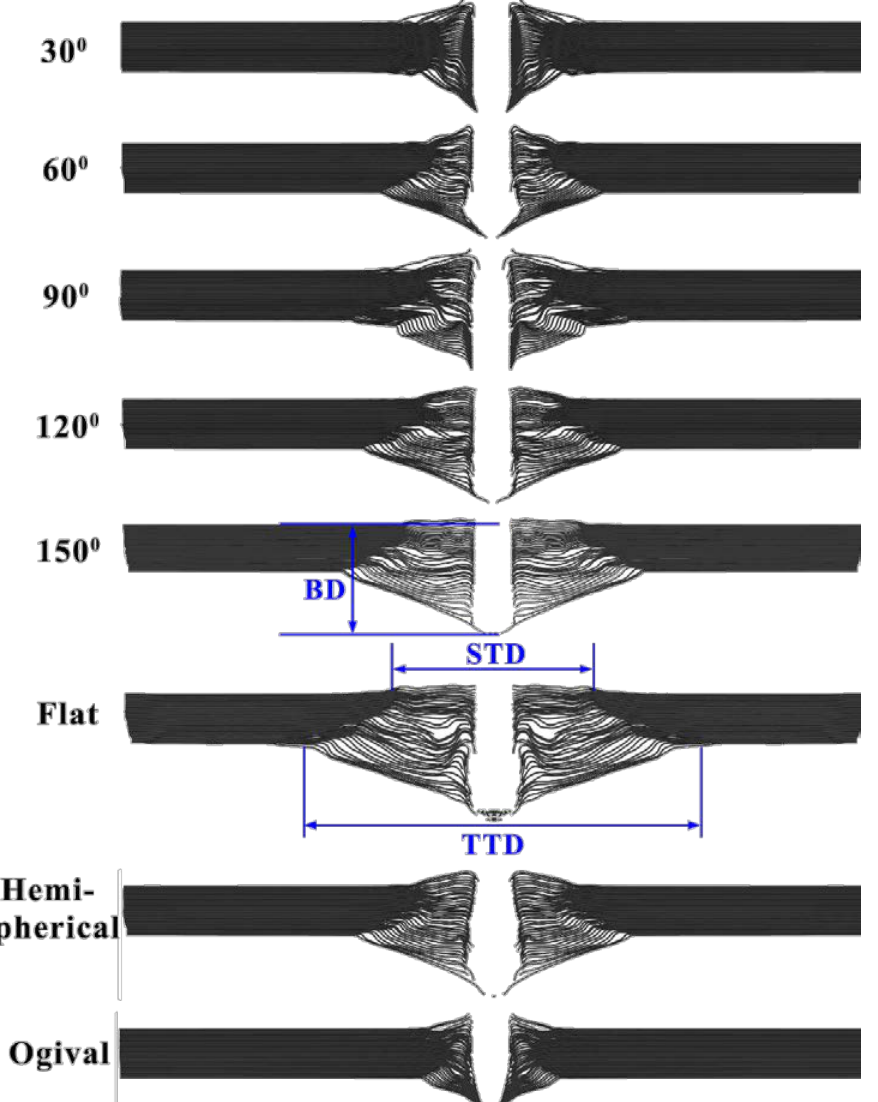
Figure 9. The macro-profile features of the UHMWPE composite impacted with various nose shape projectile. Table 6. The deformation parameters of the UHMWPE composite in simulations.